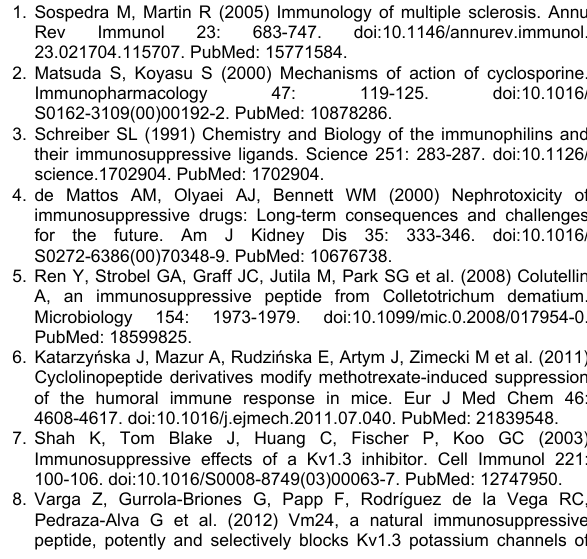
(TIF) Figure S4. Ca 2+ -release in human T-cells. ( A ) The Figure S1. Folding/cyclization and purification of [T20K] fluorescence time course of Fura-2 loaded human primary T- kalata B1. ( A ) HPLC profile of [T20K] kalata B1 after a one- cells was measured by extinction at 340 and 380 nm, pot oxidation/cyclization procedure. The late eluting peak respectively and emission at 510 nm in 30 sec intervals, while (indicated with an asterisk) was confirmed to be the correctly continuously shaking. Ca 2+ -influx was initiated by adding folded [T20K] by NMR spectroscopy (Figure 1). ( B ) The purity compounds to the cells (illustrated by the arrow). To receive of [T20K] kalata B1 was evaluated by analytical RP-HPLC. The maximum Ca 2+ -release, cells were triggered with PMA (50 sharp and symmetrical peak suggests that the purity of T20K is ng/mL) and ionomycin (500 ng/mL) (reversed triangles). For >95%. lowest Ca 2+ -levels, cells remained untreated (diamond-shapes, (TIF) dotted line). Stimulation with [T20K] kalata B1 (open squares), [V10K] kalata B1 (open triangles) or cyclosporin A (open Figure S2. Effects of cyclotide mutants on cell circles) (4 µM each) did not induce any change in Ca 2+ - proliferation of activated primary purified human T- signaling. ( B ) Ca 2+ -flux was additionally analyzed by FACS cells. The proliferation capacity of CFSE-labeled primary using Fluo-4 and Fura Red labeled T-cells, which were purified T-cells were analyzed at day 3 in the presence of pretreated with cyclosporin A or cyclotides for 16 h. None of the medium (ctrl), camptothecin (CPT, 30 µM), cyclosporin A (CsA, compounds [T20K] kalata B1, [V10K] kalata B1 or cyclosporin 0.8 µM) or different concentrations of the kalata B1 cyclotide A induced an inhibition of Ca 2+ -release after addition of PMA mutants (1.8-14 µM). Data are presented as mean ± SD of and ionomycin (indicated by the arrow). three (two for [T20K] kalata B1) independent donors and experiments. The corresponding IC values have been 50 presented in Table 1.